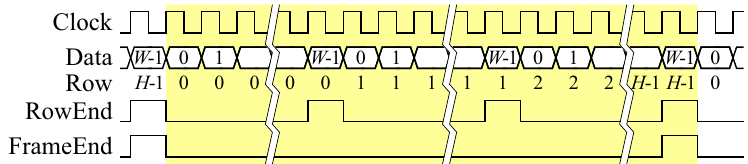
Figure 6. Continuous pixel stream protocol, with one image frame highlighted.